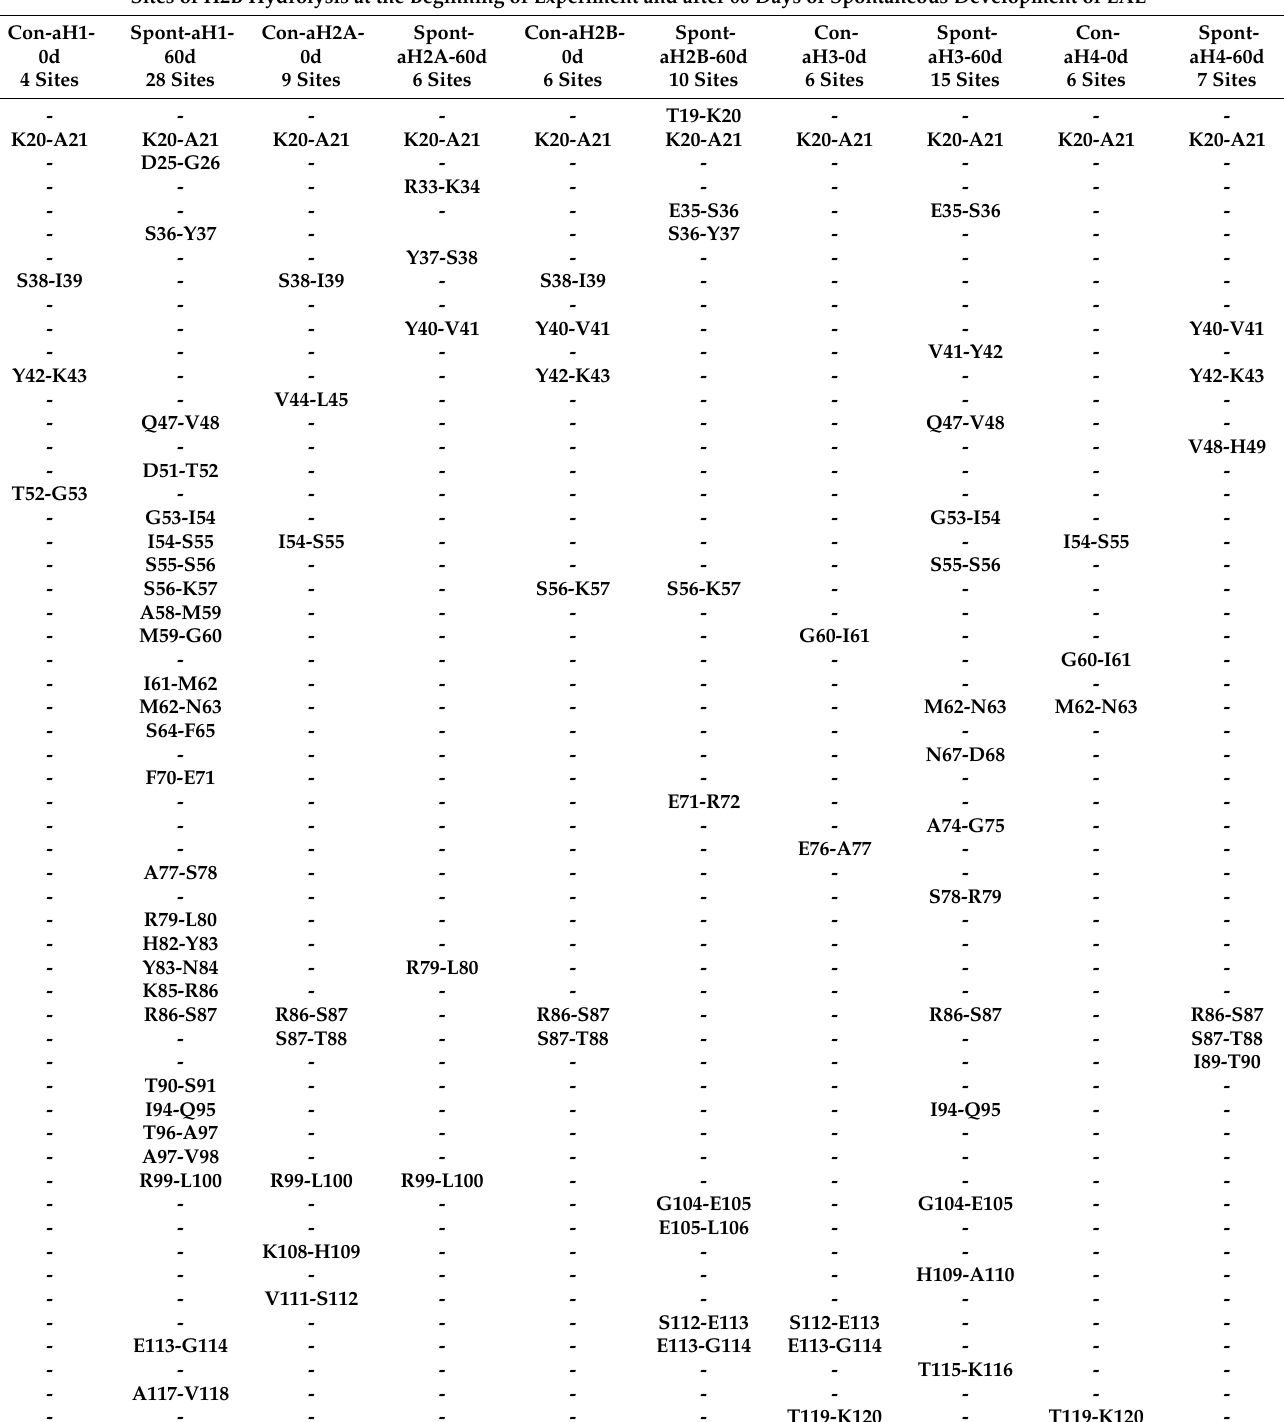
Table 2. Sites of H2B histone hydrolysis by IgGs against three individual histones at zero time and after spontaneous development of EAE during 60 days